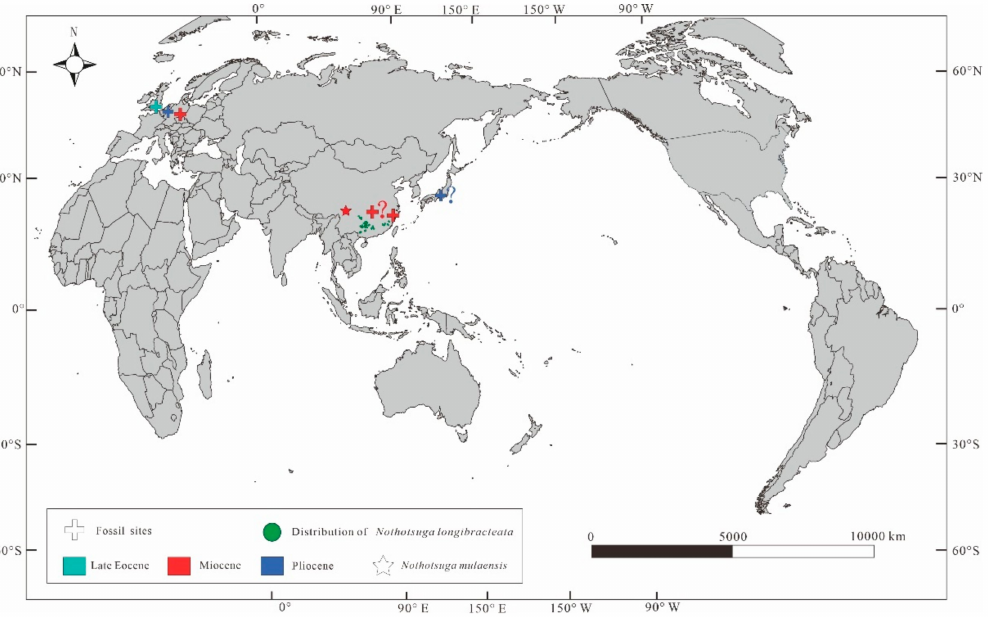
Figure 5. The spatial distribution map of fossil records and modern species of Nothotsuga [14,17,31,37].